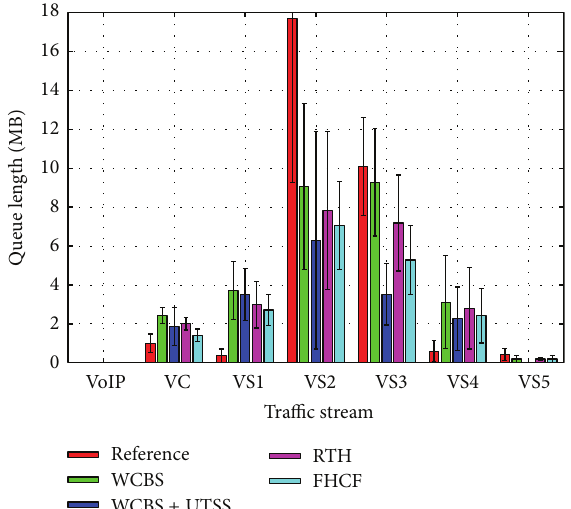
Figure 14: Packets drop rate.